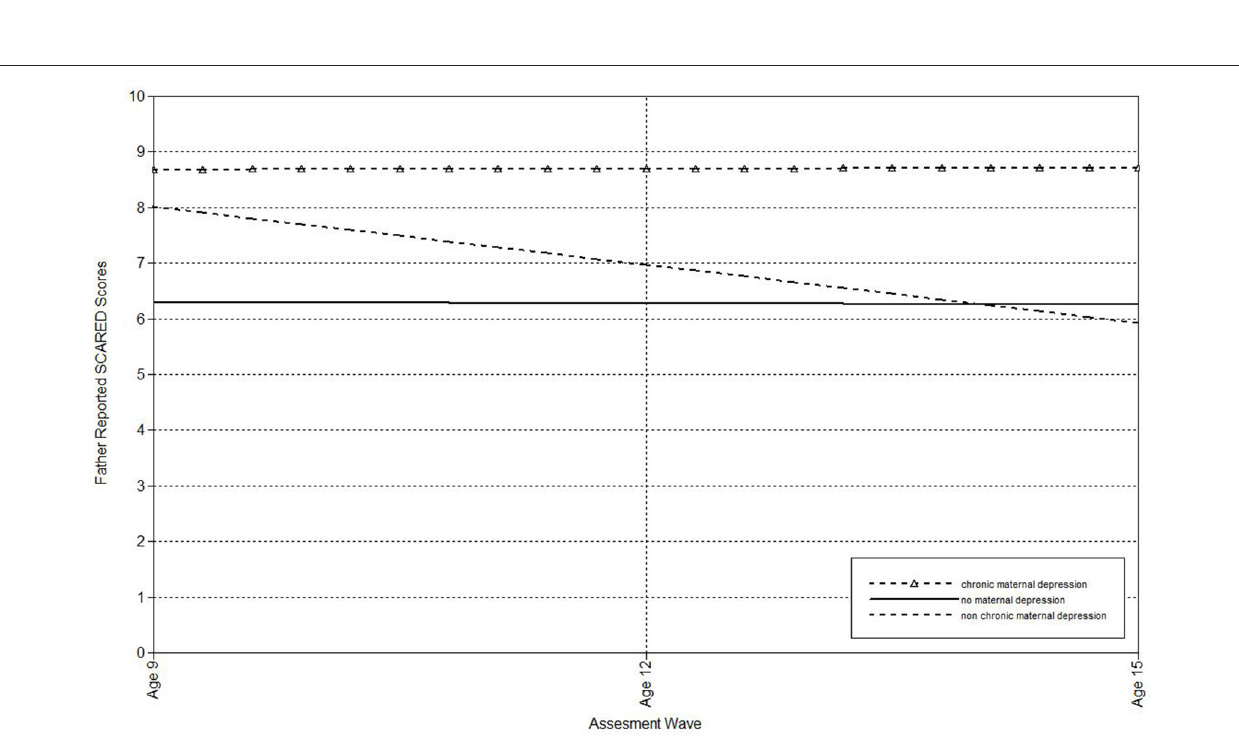
Frontiers in Psychiatry |